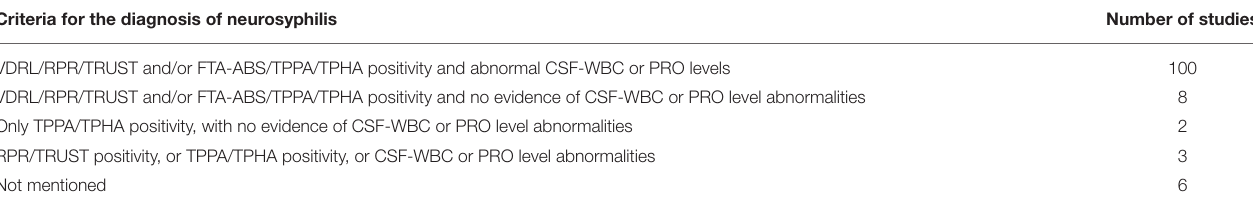
TABLE 6 | Diagnostic criteria in 93 retrospective case series and 26 studies on neurosyphilis in patients with other diseases. Criteria for the diagnosis of